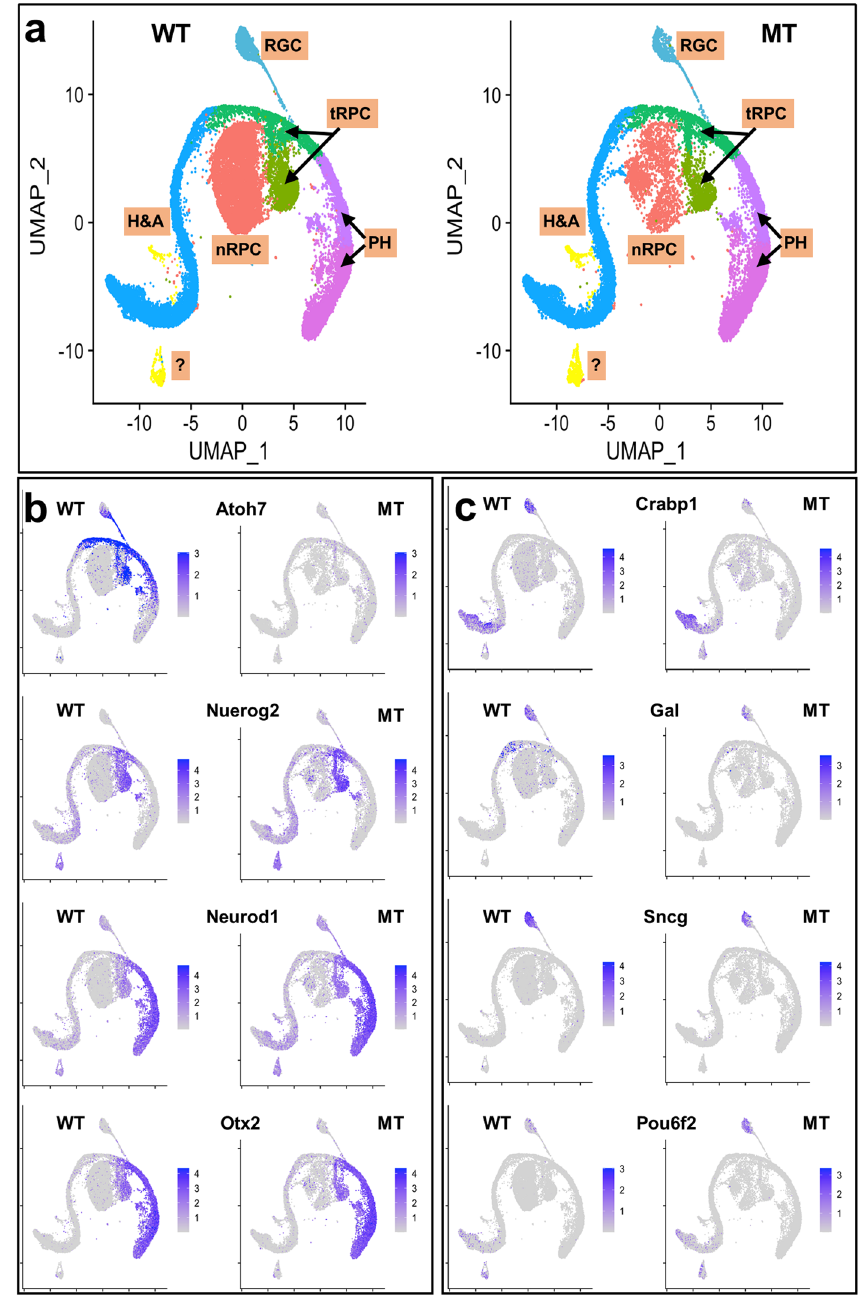
Fig. 9 Single cell RNA-seq analysis of E17.5 wild-type (WT) and Atoh7 -null (MT) cells. a Identi fi es of UMAP clusters of WT and MT retinal cells, including naive RPCs (nRPC), transitional RPCs (tRPC), retinal ganglion cells (RGCs), horizontal and amacrine cells (H&A), photoreceptors (PH). Note there are two transitional RPC clusters, two photoreceptor clusters, and a cluster (?) whose identity needs to be further con fi rmed. b Feature heatmaps showing genes expressed in transitional RPCs, including Atoh7 , Neurog2 , Neurod1 , and Otx2 in WT and MT retinas. c Feature heatmaps of a set of RGC genes in WT and MT retinas, including Crabp1 , Gal , Sncg , and Pou6f2 . Crabp1 , Gal , and Sncg are downregulated , whereas Pou6f2 is upregulated, in the MT RGCs. Color scales represent natural-log transformed normalized gene expression levels as described in “ Methods ”